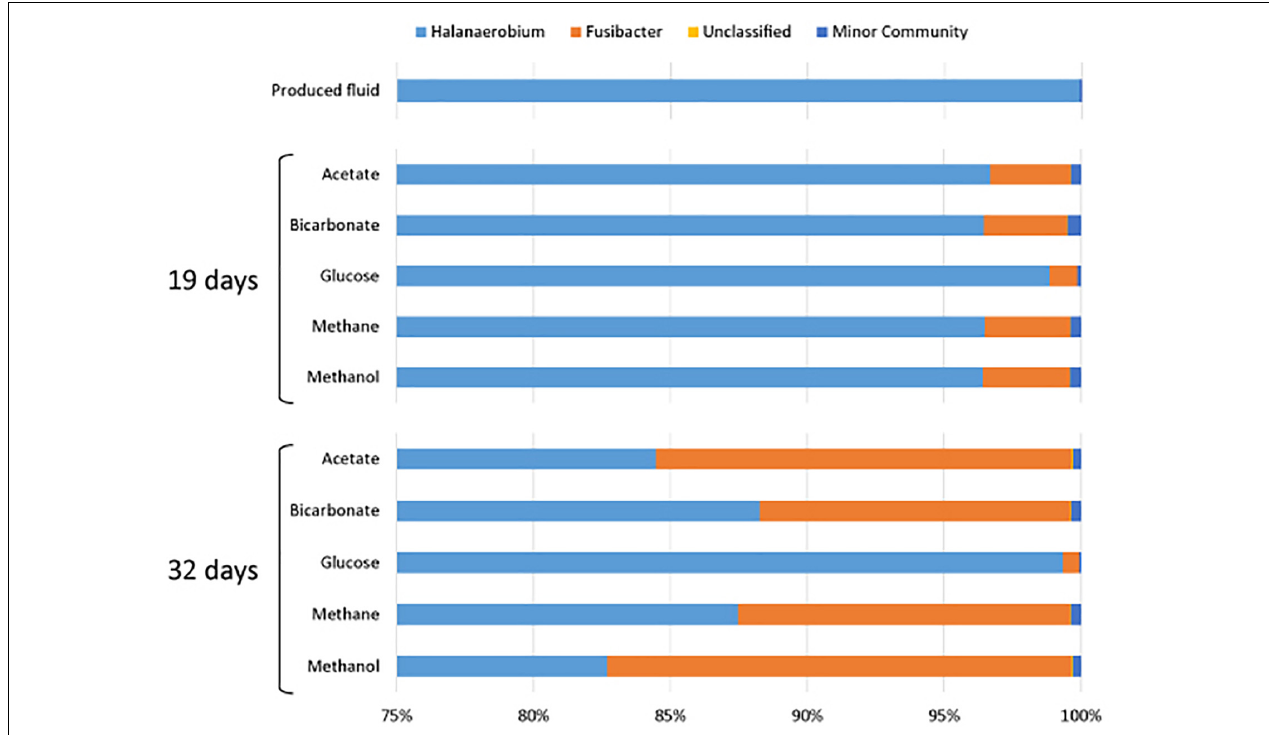
FIGURE 5 | Genera of the class Clostridia that were present in produced water after 19 and 32 days of incubations with different carbon substrates added. TABLE 2 | Sequencing and diversity estimates of the produced fluids for 19 or 32 days under anoxic conditions. Coverage Chao ACE Jackknife Shannon Carbon source Time Number of Observed (%) richness (days) sequences OTUs 0 . 03